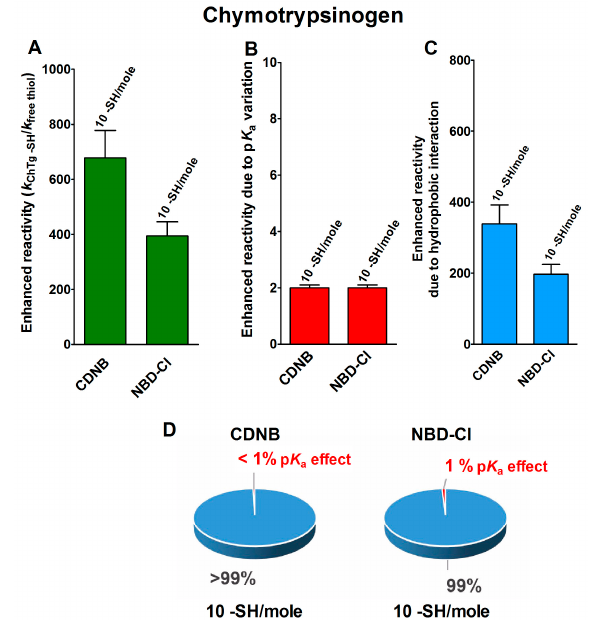
Figure 3. p K a and hydrophobic effects on the observed hyper-reactivity in the reduced chymotrypsinogen. ( A ) Experimental kinetic data for the reaction of rChTg with CDNB and NBD-Cl at pH = 5.0, normalized to those of an unperturbed protein cysteine (enhanced reactivity) [16]. ( B ) Enhanced reactivity due to the experimental lower p K a for 10 cysteines (p K a = 8.1). ( C ) Enhanced reactivity due to hydrophobic interaction. ( D ) The circle diagrams show the percent contribution of the two factors: the hydrophobic effect (blue) and the p K a effect (red). The 100% represents the sum of the values reported in panels ( B) and ( C ). The error bars in panels ( A – C ) are derived from the propagation of uncertainties (see Section